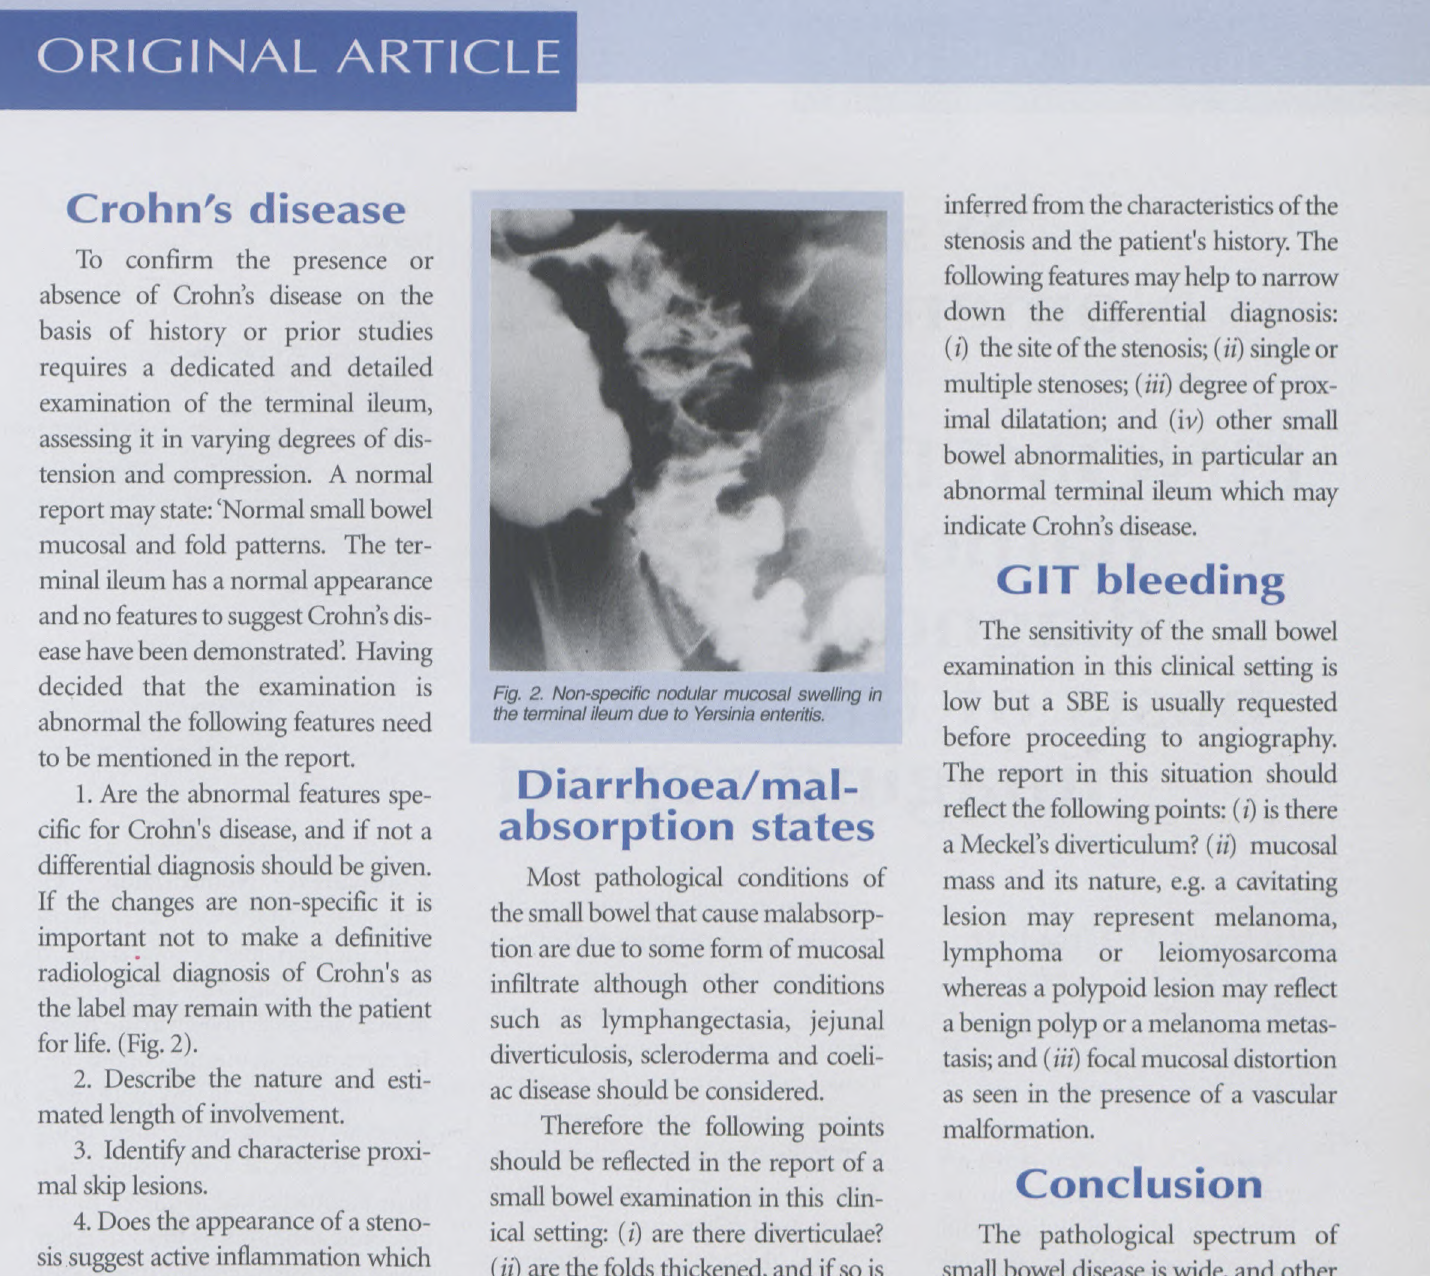
Fig. 2. Non-specific nodular rr:~cosal s"!elling in the terminal ileum due to Yersmla